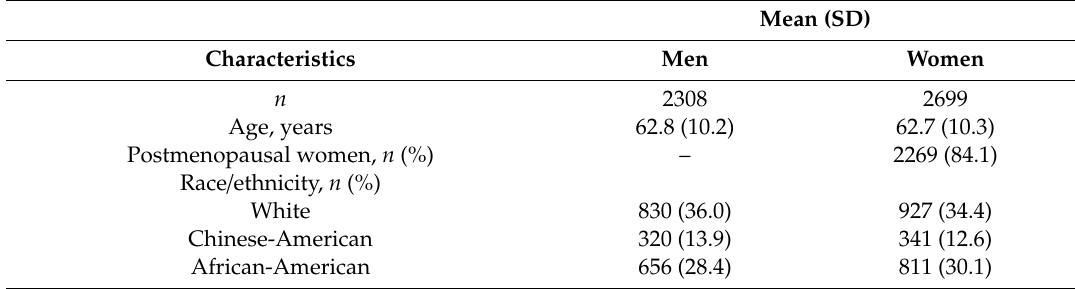
Table 1. Characteristics of 5007 participants with apolipoprotein and liver fat content measures in the Multi-Ethnic Study of Atherosclerosis at baseline